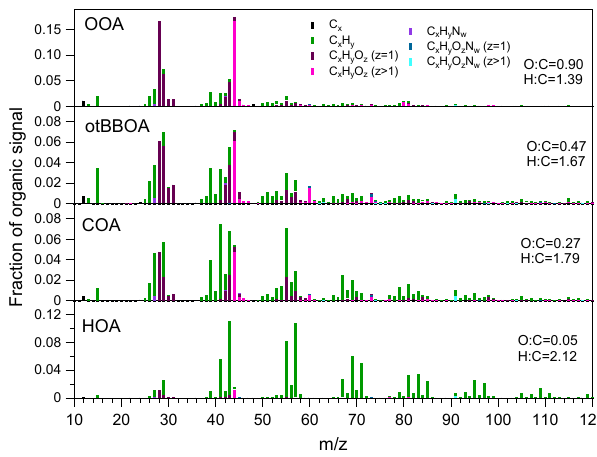
Figure 10. Mass spectra of the four PMF factors found for the mea- surement period including Fat Thursday (16 February